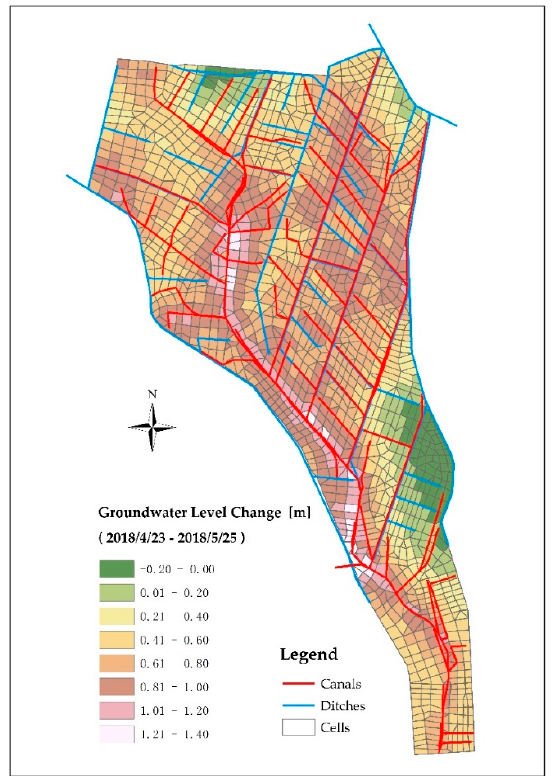
Figure 11. Groundwater level change before and after the first two irrigation rounds in 2018.